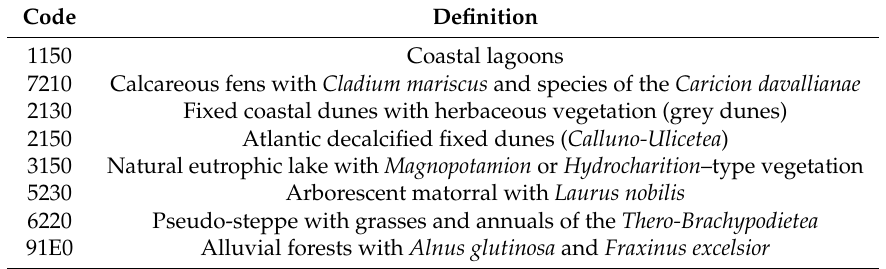
Table 1. Main, associated, and secondary habitats in the official cartography assigned to the studied lakes. The habitats that are not marked as relevant for the conservation in the official cartography were discarded. Source: Xunta de Galicia ©